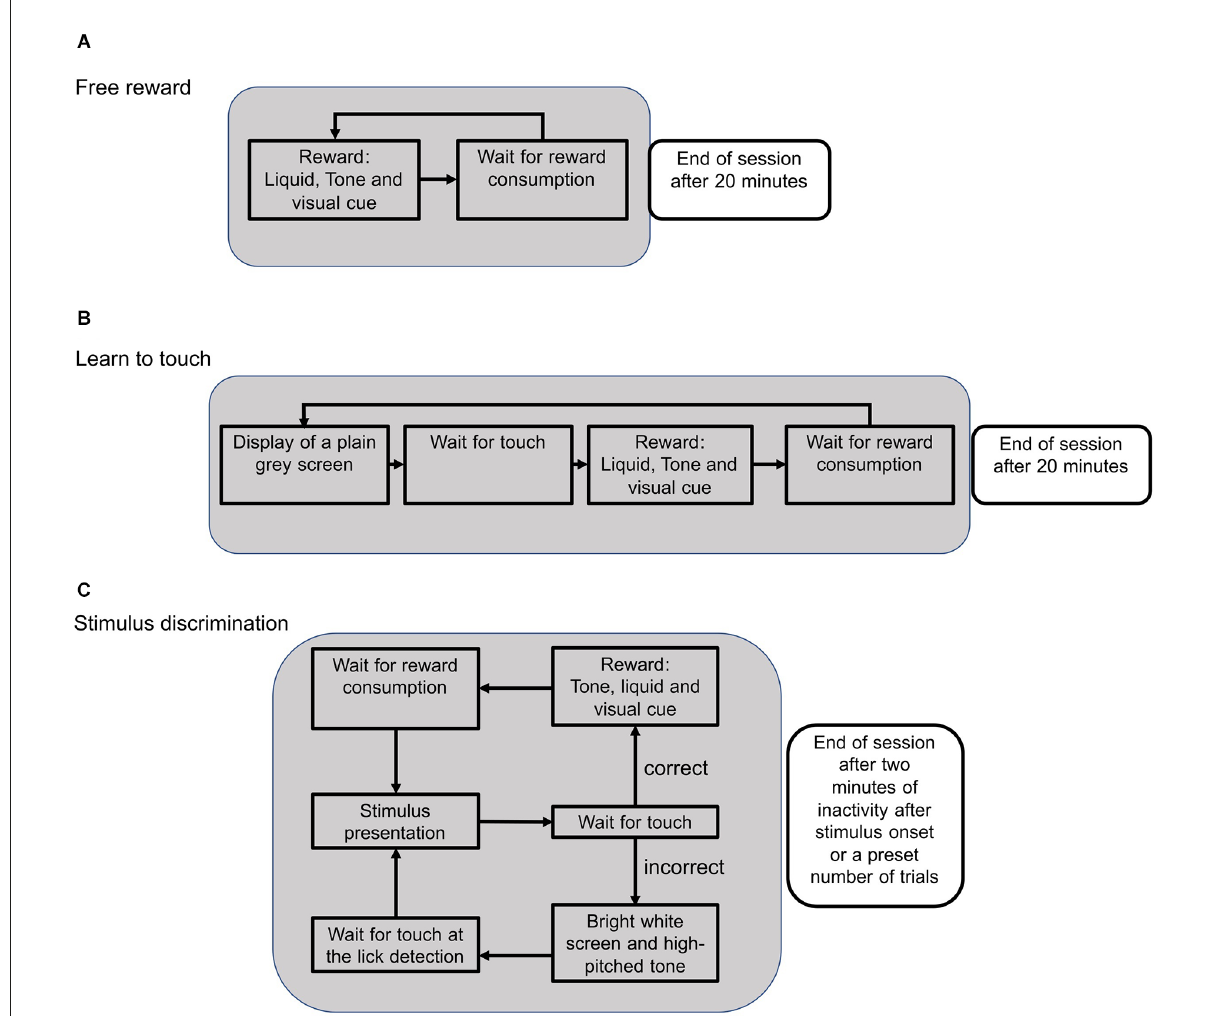
FIGURE2 Schematic flow of an experimental session during different training phases. (A) During the reward training, available rewards were indicated by a green LED as a visual cue. When the lick detection was triggered, the green LED turned off and the trial was restarted. Sessions were stopped after 20 min. (B) In the subsequent training phase, the mouse had to touch the screen in order to activate the reward system. After touching the screen, the green LED turned on and a reward could be collected to initialize the next trial. (C) During the stimulus presentation, two different stimuli were presented and the animal could either touch the target or the distractor stimulus. Touching the target position caused the onset of a visual cue and a low-pitched tone. With the consumption of the reward, the next trial was initialized. Touching the distractor position was followed by a high-pitched tone and a bright screen to signal an error. The next trial needed to be initialized by triggering the lick detection without getting a